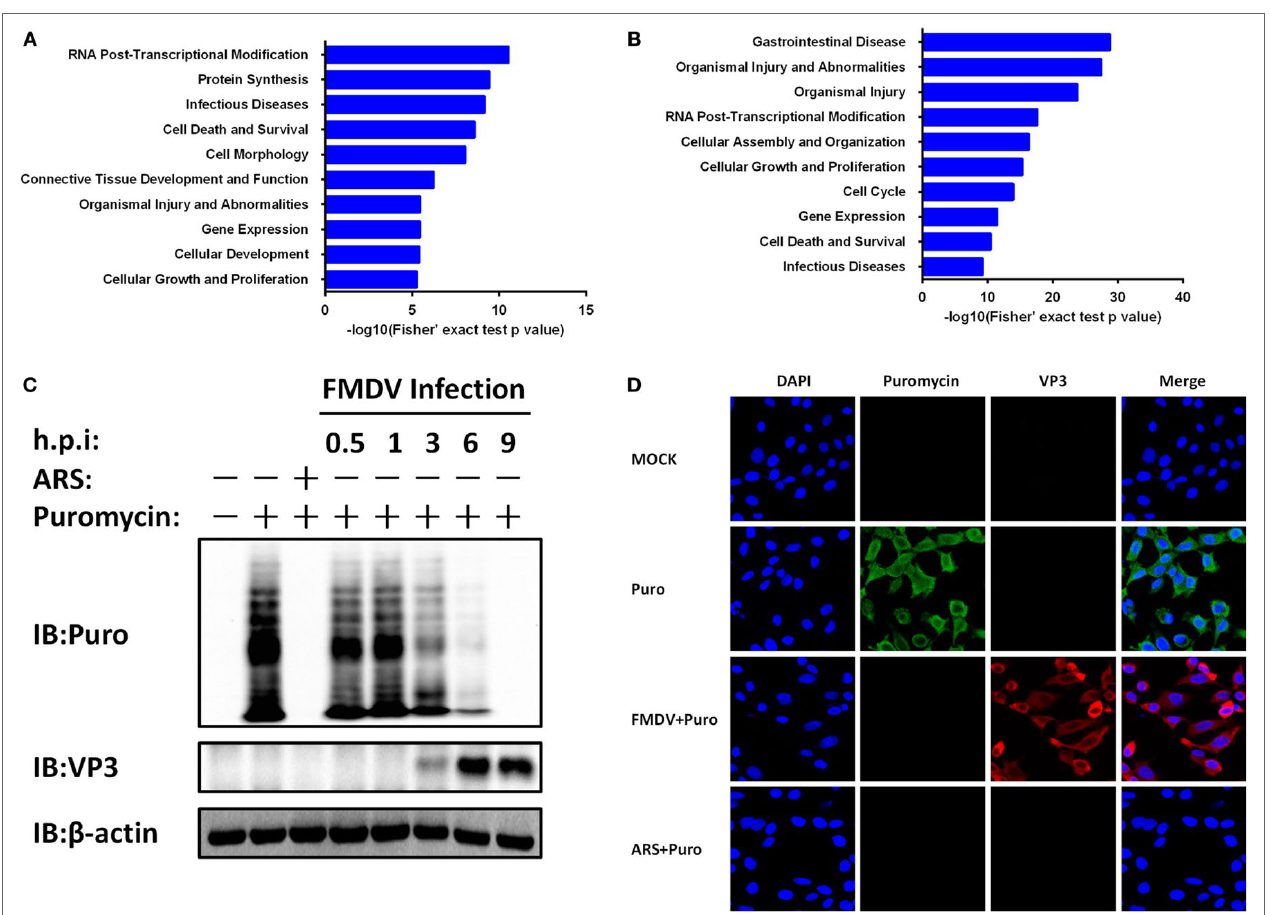
FigUre 3 | Foot-and-mouth disease virus (FMDV) infection-induced host cap-dependent translation but not cap-independent translation shutoff. (a,B) Biological function categories analysis by Ingenuity pathway analysis (IPA ® ). The top 10 biological function categories relevant to the regulated proteome (a) and phosphoproteome (B) are shown with the corresponding score ( − log [ p value]). (c) IBRS-2 cells were mock-infected or infected with FMDV at 5 MOI for 0.5, 1, 3, 6, and 9 h, or treated with arsenite for 30 min at 37°C. Puromycin (25 µg/ml) was then added to the medium in each well for 15 min. The cells were lysed and analyzed by western blotting. Protein synthesis was determined using puromycin labeling followed by immunoblot with the anti-puromycin mAb. FMDV VP3 level was monitored by immunoblot with anti-FMDV VP3 protein antibodies. Beta-actin ( β -actin) detection was used to confirm equal sample loading. (D) IBRS-2 cells were mock-infected or infected with FMDV at 5 MOI for 6 h, or treated with arsenite for 30 min at 37°C. Puromycin (25 µg/ml) was then added to the medium in each well for 15 min. The cells were fixed for indirect immunofluorescence assays with the following antibodies: rabbit anti-FMDV VP3 (red) and mouse anti-puromycin (green). Nuclei were counterstained with DAPI (blue). Fluorescent images were acquired with a confocal laser scanning